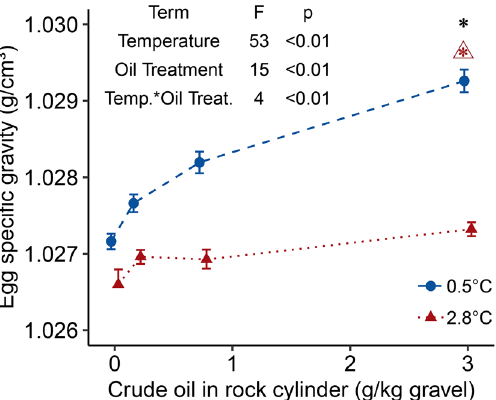
Figure 4. The effect of temperature and WSF crude oil exposure on embryo specific gravity (g/cm 3 ) before 50% hatch in the respective temperature groups (day 29 in 2.8 °C and day 56 in 0.5 °C) displayed as treatment means (± SEM depicted as bars, each point includes mean values from four incubators, each with 20 embryos). Colors and shapes distinguish temperature groups. Fitted dashed lines are the results of a GLS model using incubator as a random factor. The terms of the best gls model for embryo specific gravity and the ANOVA test F-values and p-values are displayed. An asterisk (*) above a treatment group indicates a statistically significant difference from the unexposed group, a triangle (open triangle) with an asterisk indicates a statistically significant interaction between temperature and crude oil exposure at the adjacent crude oil treatment group.